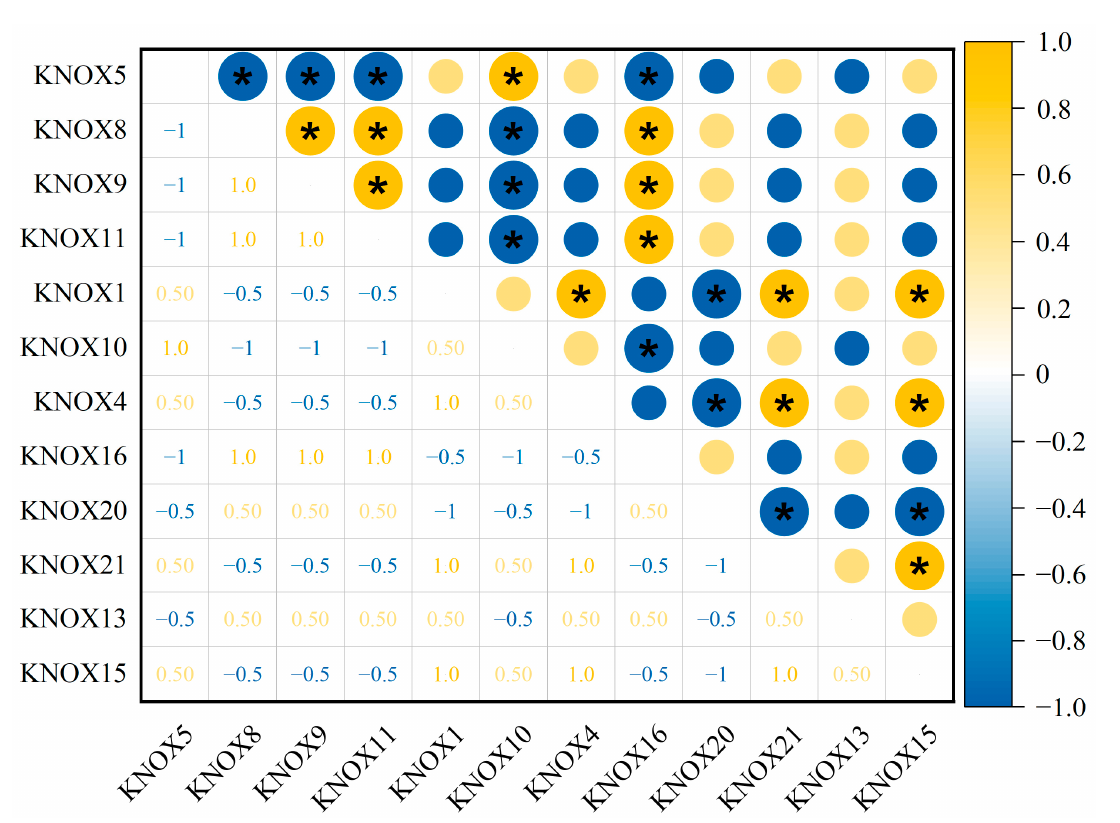
Figure 7. The correlations between the TrKNOX gene relative expression. Yellow: positively corre- lated; blue: negatively correlated. The marks of * indicate significant differences ( p ≤ 0.05, Spearman) among the treatments.